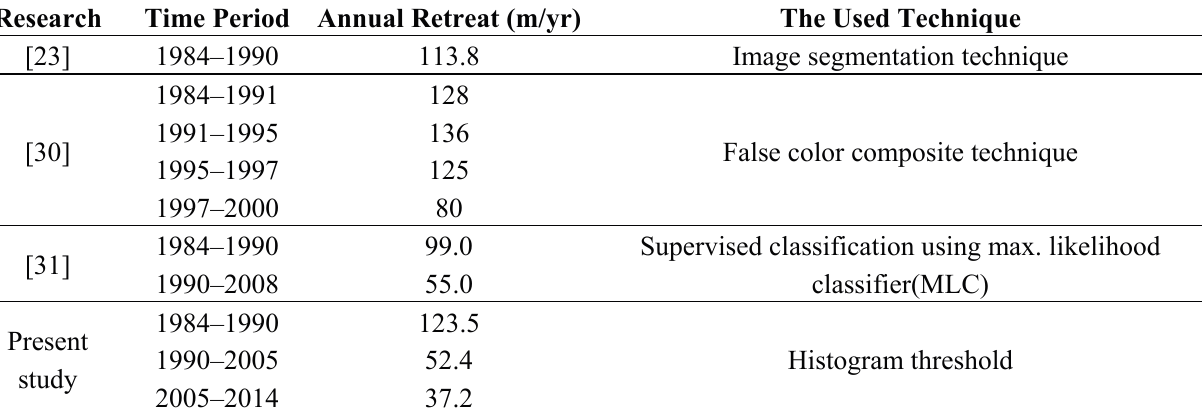
Table 7. Comparison between previous studies and the present